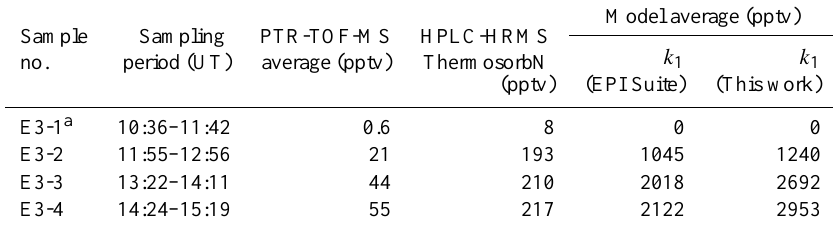
Table 7. Measured and modelled mixing ratios (pptv) of 2-nitroamino ethanol in experiment E3 as averages for certain sampling periods before and during the sunlit experiment. Modelled concentrations are shown using the rate constant k( OH + MEA ) value 1) estimated by EPI SuiteTM v4.0 and 2) obtained in this